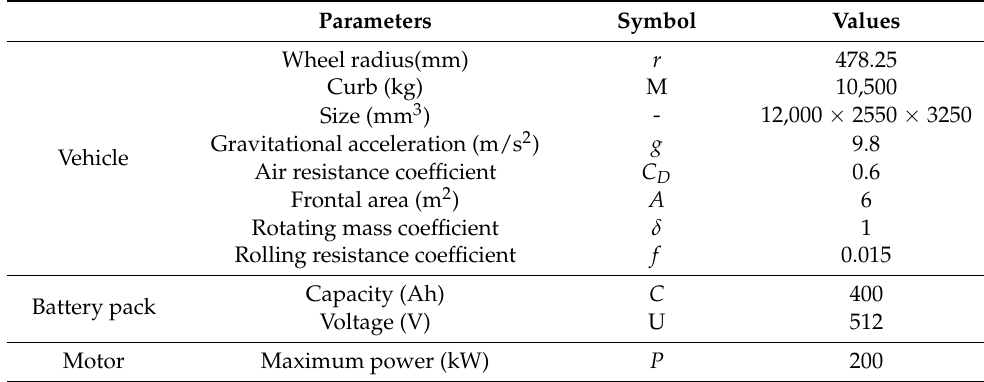
Table 11. Main parameters of